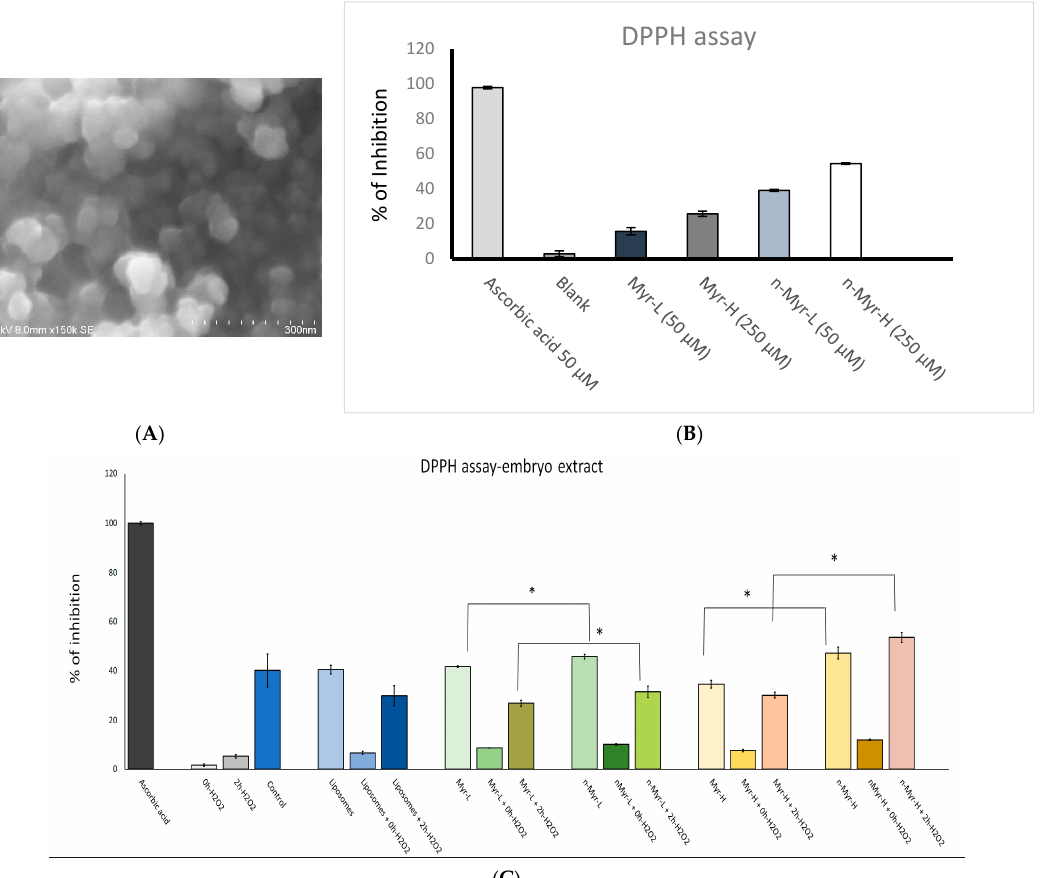
Figure 3. ( A ) SEM image of liposome ‐ encapsulated myricetin. ( B ) The percentage inhibition of DPPH by low (50 μ M) and high (250 μ M) doses of myricetin and liposomal ‐ encapsulated myricetin. Ascorbic acid (50 μ M) was taken as a positive control. ( C ) Zebrafish embryos were treated with only liposomes, Myr ‐ L, Myr ‐ H, n ‐ Myr ‐ L, and n ‐ Myr ‐ H for 24 h. After 24 h, H 2 O 2 treatment (3 mM), DPPH radical ‐ scavenging assay was carried out immediately and 2 h after treatment. Un ‐ treated embryos were taken as controls for the treated groups, and ascorbic acid was taken as a positive control (* denotes p < 0.001).